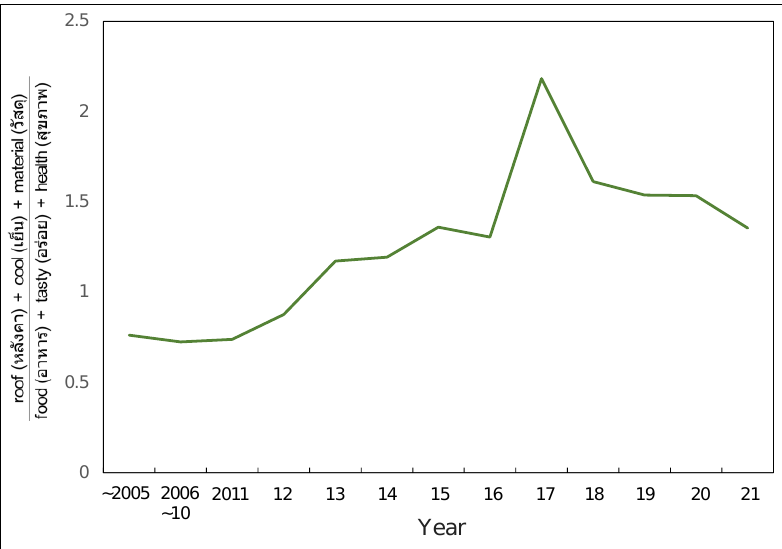
Figure 7. Relative abundance of roof and cooling-related documents based on a Google document keyword